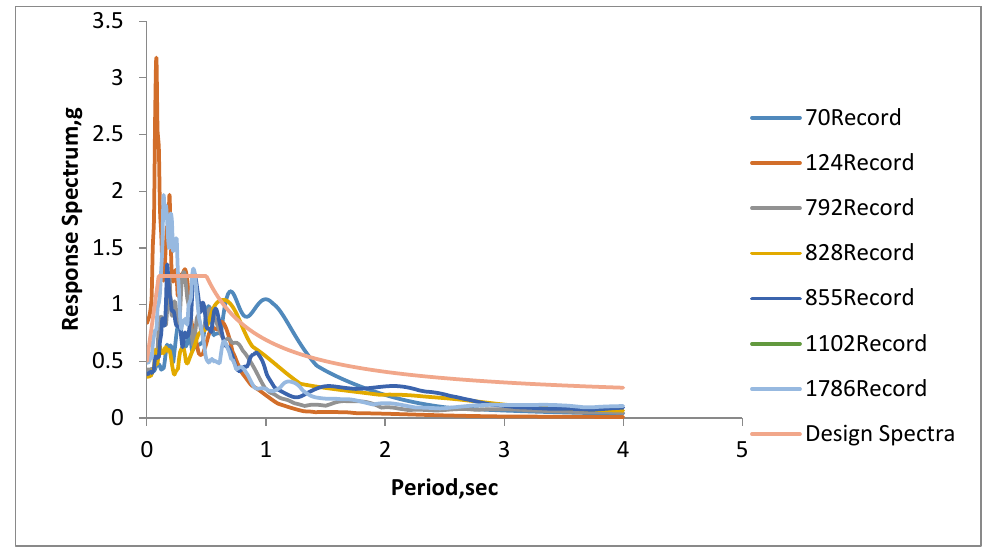
Fig. 4. Comparison of reflectance spectra of selected accelerograms.